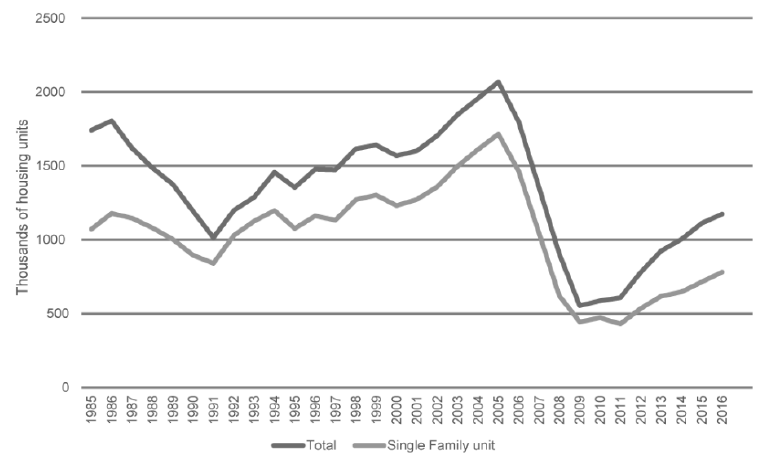
Figure 7. Annual gross gains, gross losses, and net change for land-cover classes ( a ) developed and ( b ) water. Median standard error (SE) in square kilometers: developed — gain, ±1252; loss, ±457; and net, ±1333; Water — gain, ±723; loss, ±646; and net, ±1022.